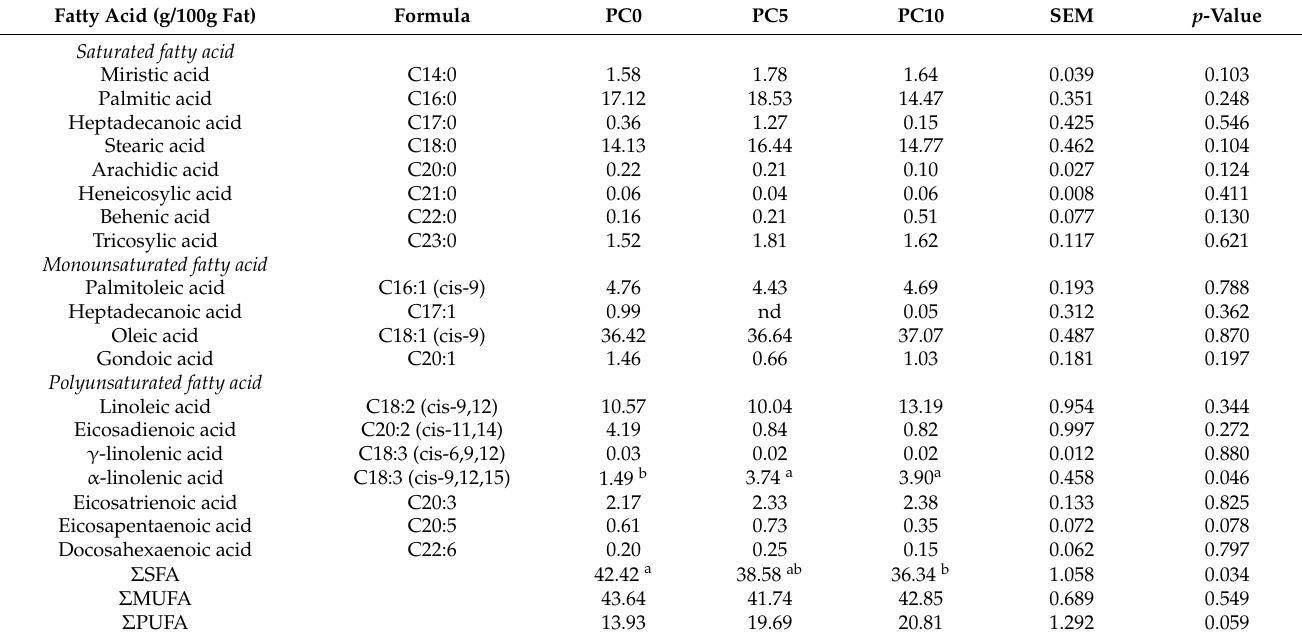
Table 7. Effect of dietary perilla cake supplementation on the fatty acid profile in the abdominal fat of growing pigs. Fatty Acid (g/100g